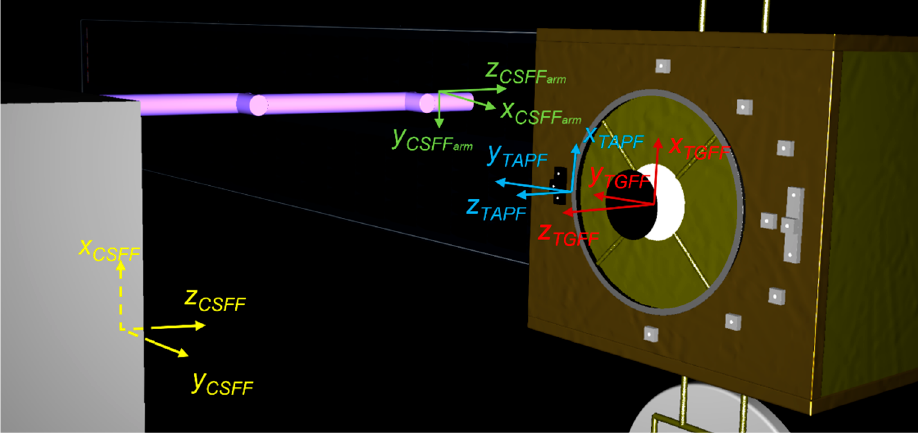
Figure 1. Target and chaser spacecraft as modelled in PANGU, with representation of the reference frames being